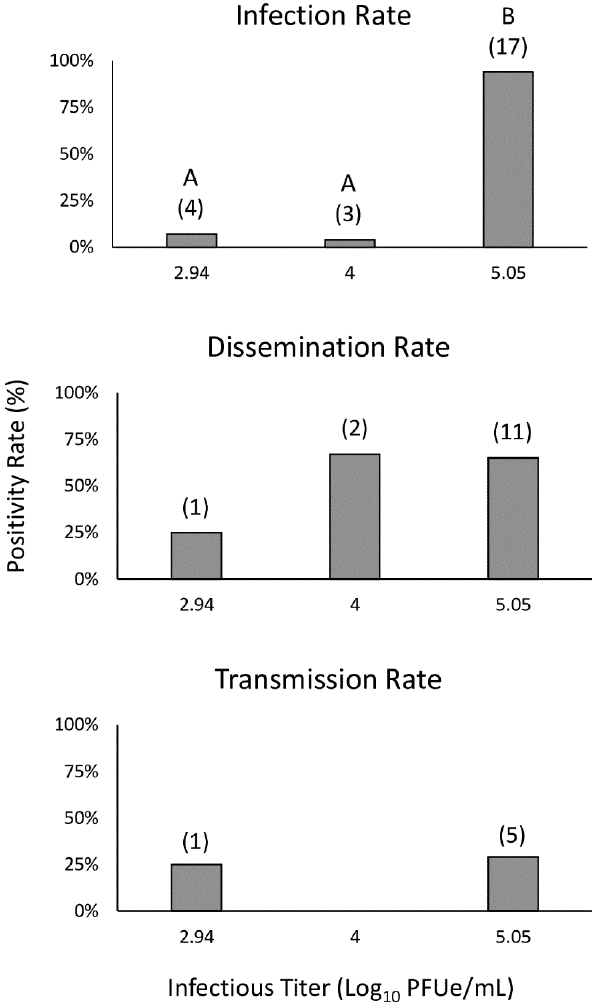
Figure 2. Infection, dissemination, and transmission rates for per os infection trials conducted with three infectious titers of EHDV-2. Fisher’s exact tests indicated significant differences in infection rates ( p < 0.001). Pairwise significance is indicated above bars for infection rates. Infection rates were not significantly different between the 2.94 and 4.00 log 10 PFUe/mL infections (A); however, infection rates were significantly higher when midges were fed an infectious titer of 5.05 log 10 PFUe/mL (B) than when they were fed either of the lower titers tested. No significant difference was found for dissemination rates ( p = 0.22) or transmission rates ( p = 0.47), so pairwise significance was not tested. Numbers in parenthesis indicate the number of positive